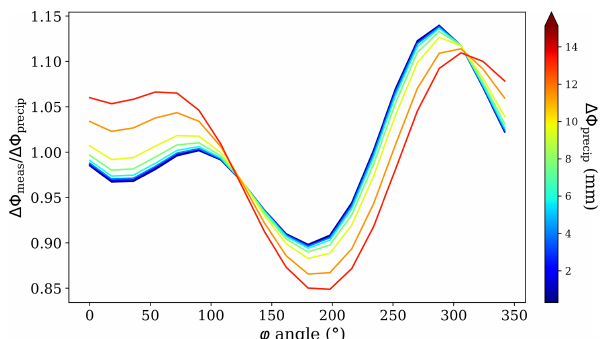
Figure 14. Ratio between the measured (cid:49)(cid:56) and the precipitation- induced (cid:49)(cid:56) precip as a function of the complex angle ϕ in ae iϕ , for a = 17 and for different values of precipitation. The value of (cid:127) 2 = 10 ◦ . The precipitation values range between an induced (cid:49)(cid:56) precip of 0.1mm (bluer) to 15mm